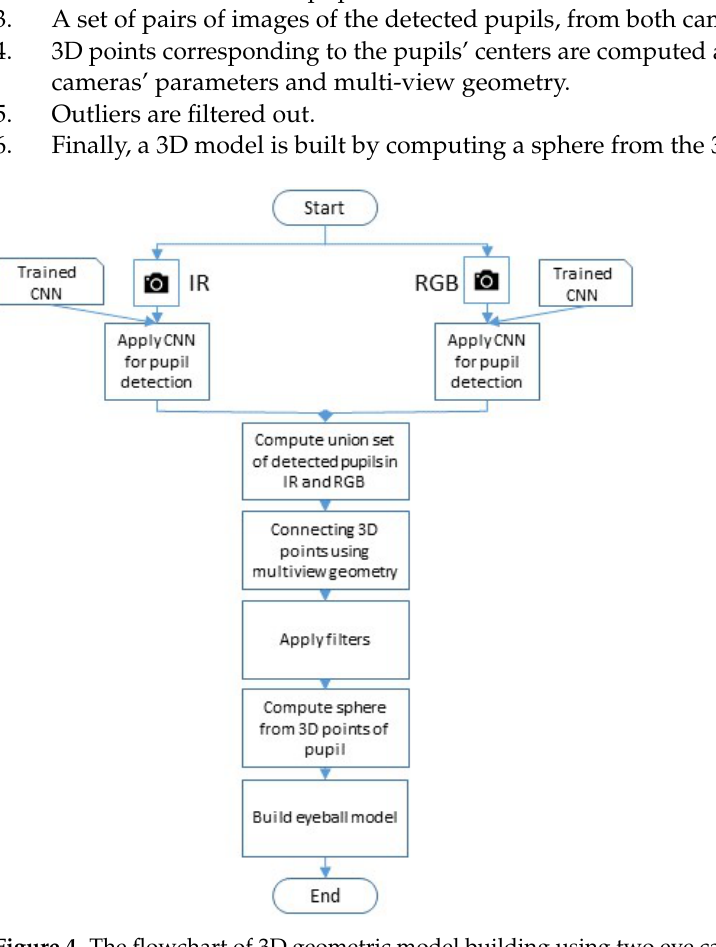
Figure 4. The flowchart of 3D geometric model building using two eye